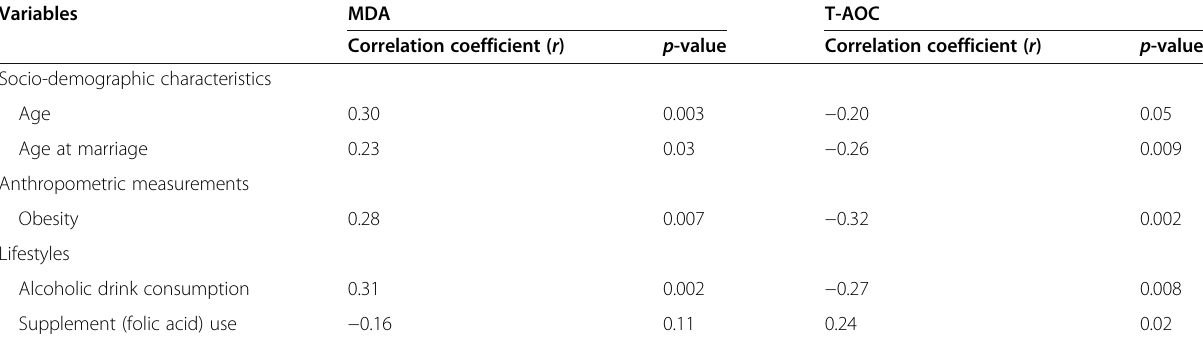
Table 5 Correlation of oxidative stress biomarkers (MDA and T-AOC) with socio-demographic, anthropometric and lifestyle